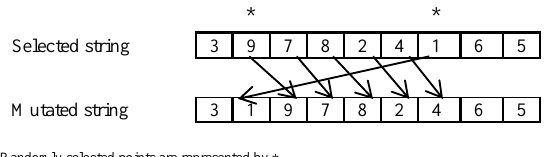
Figure 3 . Illustration of the mutation procedure Step 5. Local